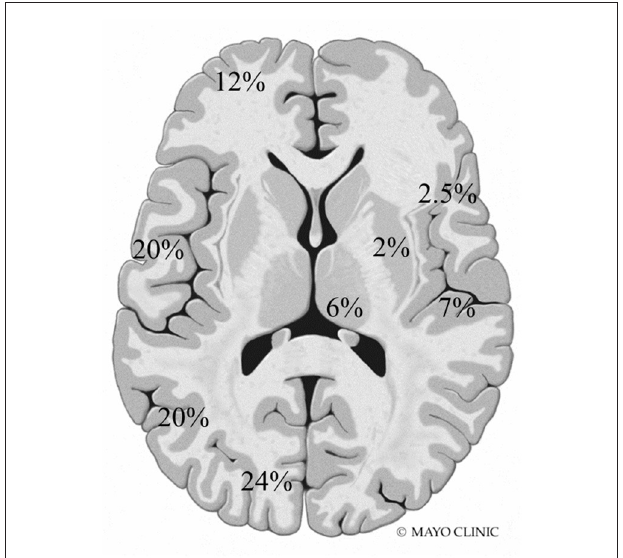
FIGURE 1 | Frequency and location of MRI abnormalities. Right side: insula, perirolandic, basal ganglia, and thalamus. Left side: frontal, temporal, parietal, and occipital lobes (not shown: brainstem 0.5% and cerebellum 5%).